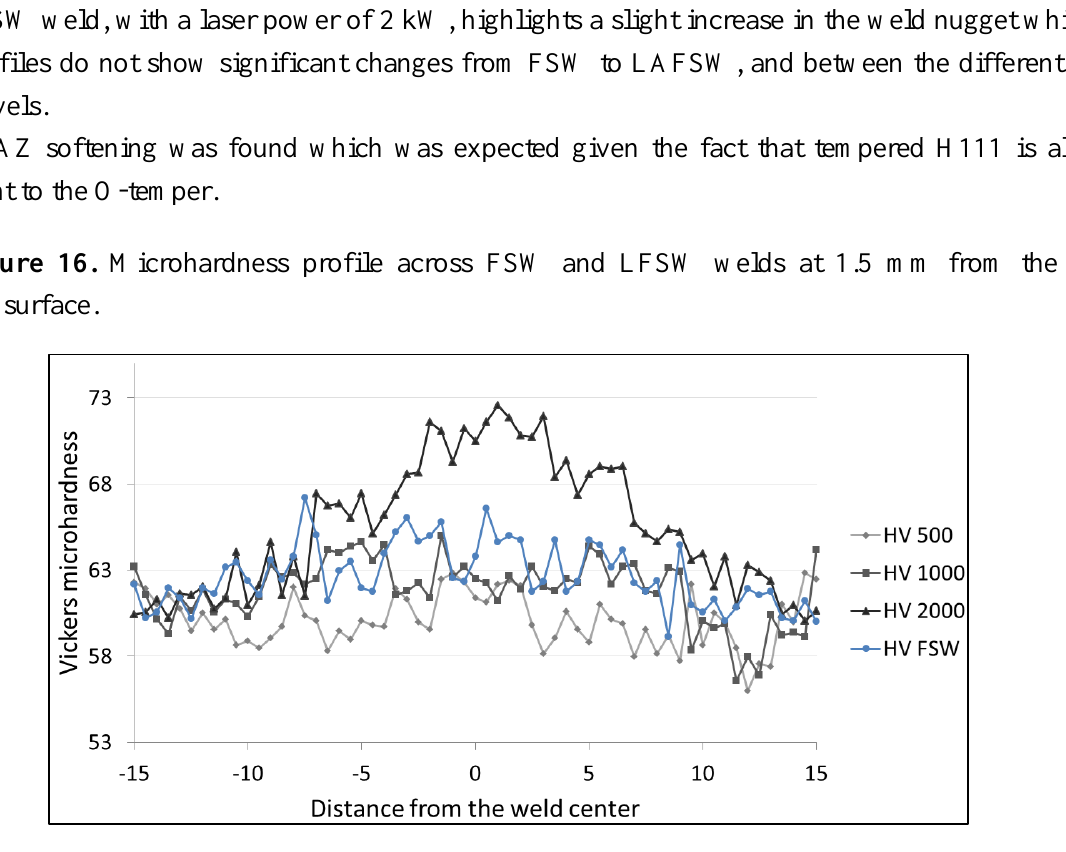
Figure 17. Microhardness profile across FSW and LFSW welds at the